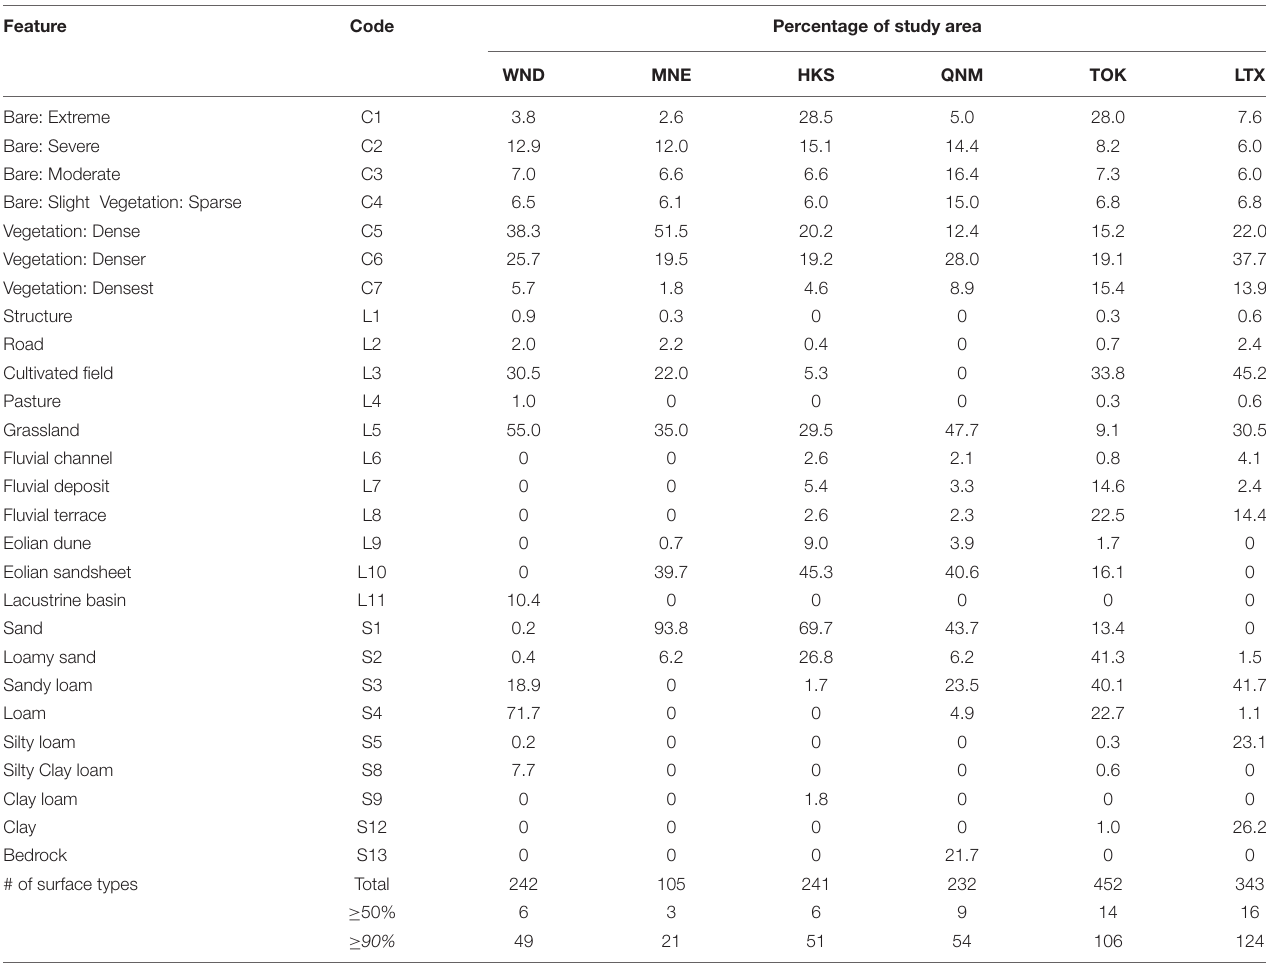
TABLE 4 | Distribution of quantified landscape variables across the six study counties, number of unique surface types classified, and number of surface types accounting for at least 50% and 90% of the study area. Feature